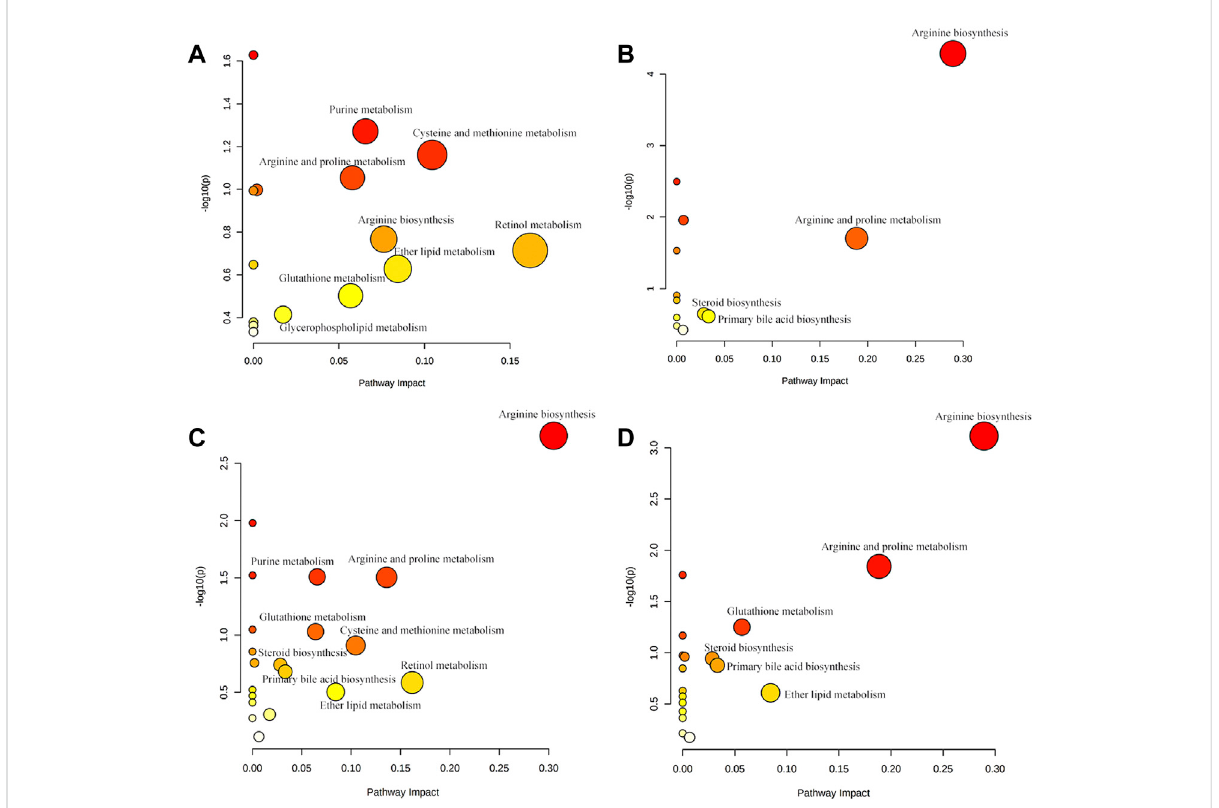
FIGURE 6 (A) Main metabolic pathways ofpotential biomarkers analyzed byLC-QTOF/MS. (B) Main metabolicpathways of potential biomarkers analyzed by GC-MS (C) The main metabolic pathways of potential biomarkers analyzed by LC-QTOF/MS and GC-MS. (D) Regulatory pathway analysis of AR